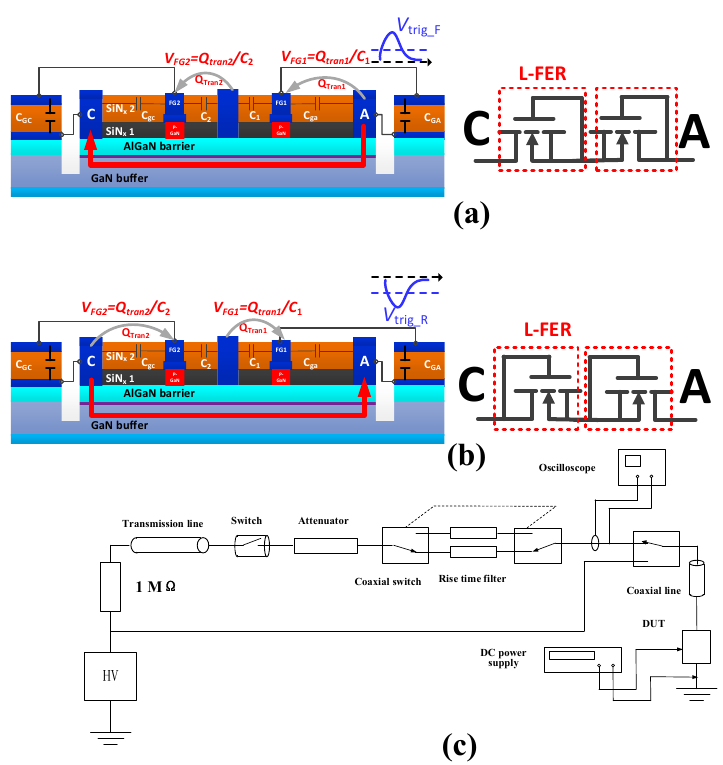
Figure 3. Working mechanism of the proposed AlGaN/GaN B-ESD-PD: ( a ) during a forward transient ESD event, ( b ) during a reverse transient ESD event, and ( c ) the schematic structure for the ESD measurement